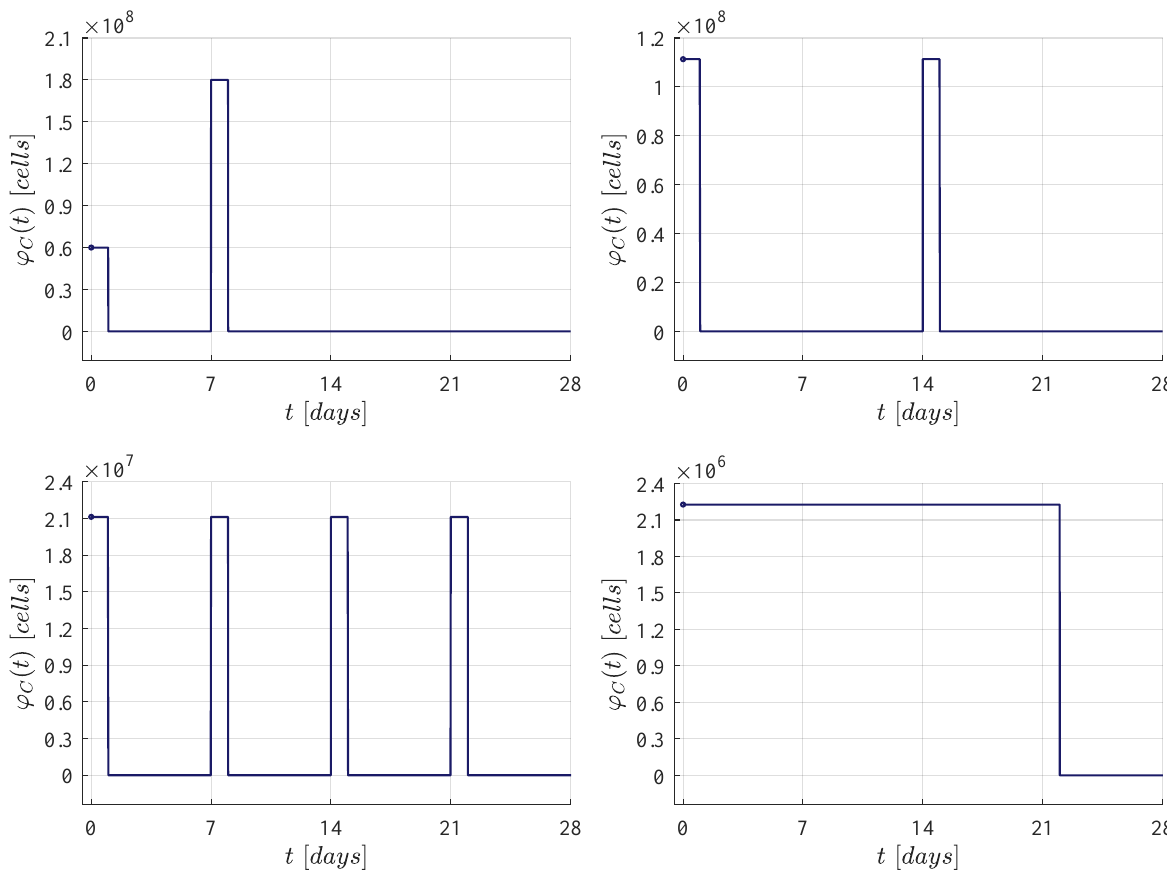
Figure 1. CAR-T cells therapy administration protocols for CR by day 28. Upper left panel: Dose 1 of 6 × 10 7 at day 0, and dose 2 of 1.8 × 10 8 at day 7, this protocol was applied in the Lee et al. [11] clinical trial. The following results were determined by means of in silico experimentation and the ALL cancer cells eradication condition (6). Upper right panel: Two doses of approximately 1.114 × 10 8 at days 0 and 14. Lower left panel: Four doses of approximately 2.115 × 10 7 at days 0, 7, 14 and 21. Lower right panel: Daily doses of approximately 2.227 × 10 6 from days 0 to